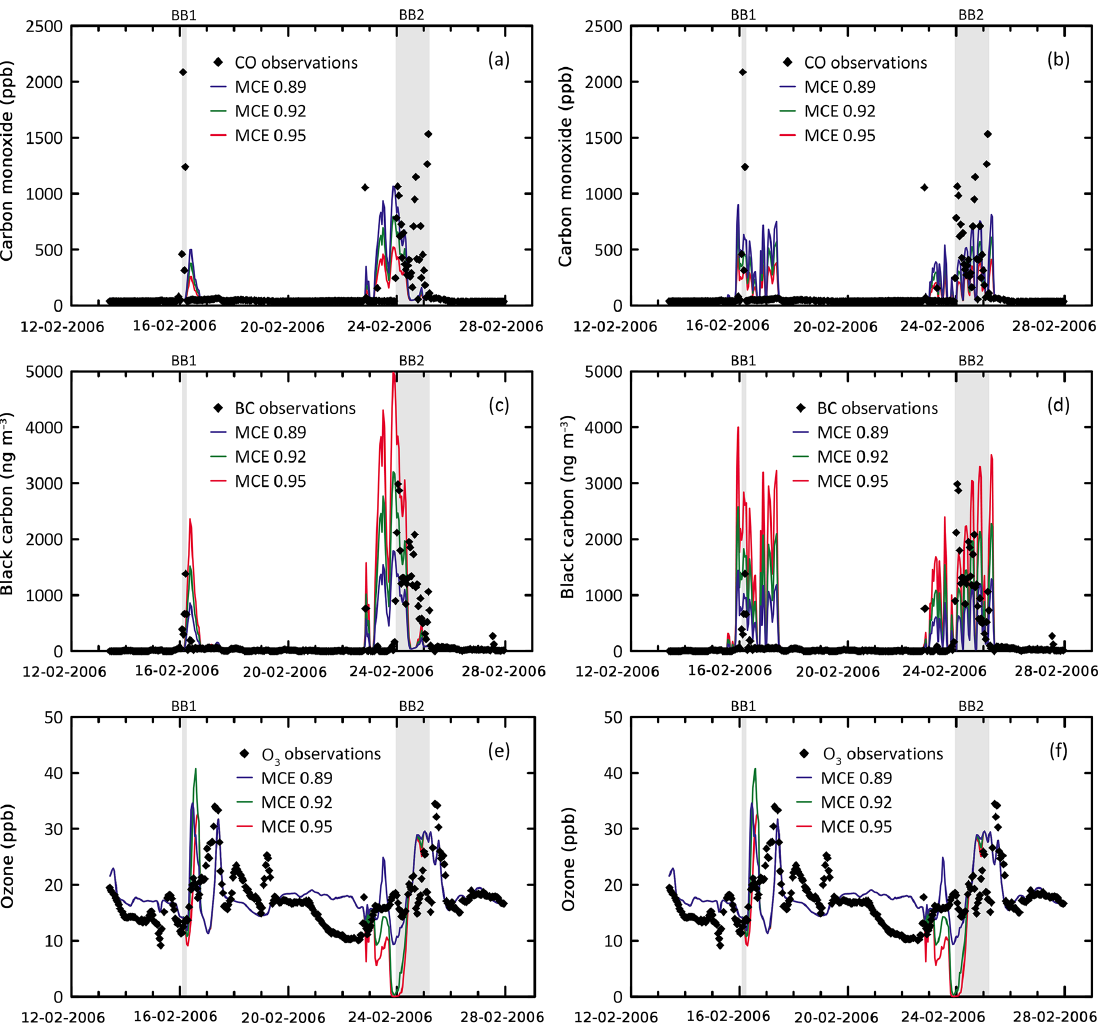
Figure 6. Simulated CO using (a) TAPM–CTM and (b) CCAM–CTM, simulated BC using (c) TAPM–CTM and (d) CCAM–CTM, and simulated O 3 using (e) TAPM–CTM and (f) CCAM–CTM. Coloured lines represent different MCE EF simulations; black symbols are